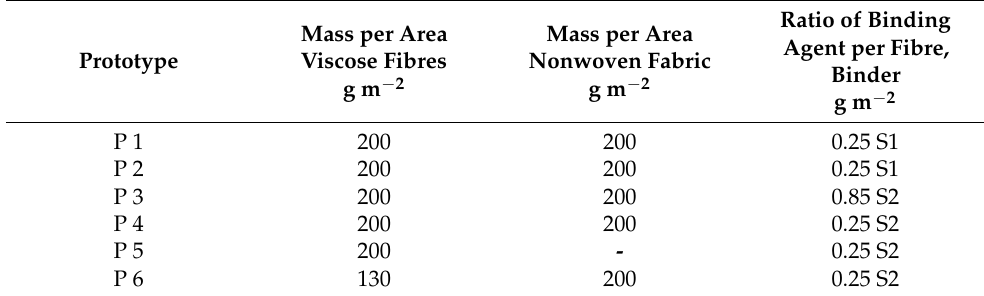
Table 1. Compositions of various geotextile prototypes for the degradation tests (binder: S1 mal- todextrin, S2 corn starch).